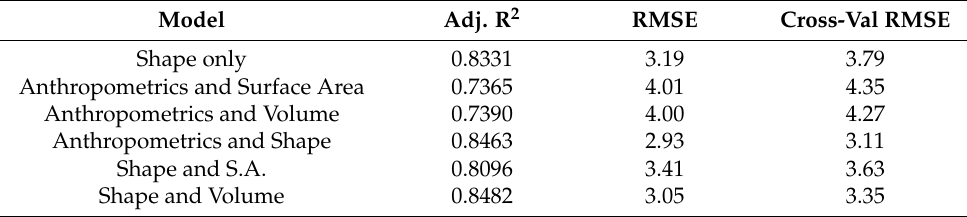
Table 3. Performance of models predicting the proportion of body fat in percentage points. Model Adj. R 2